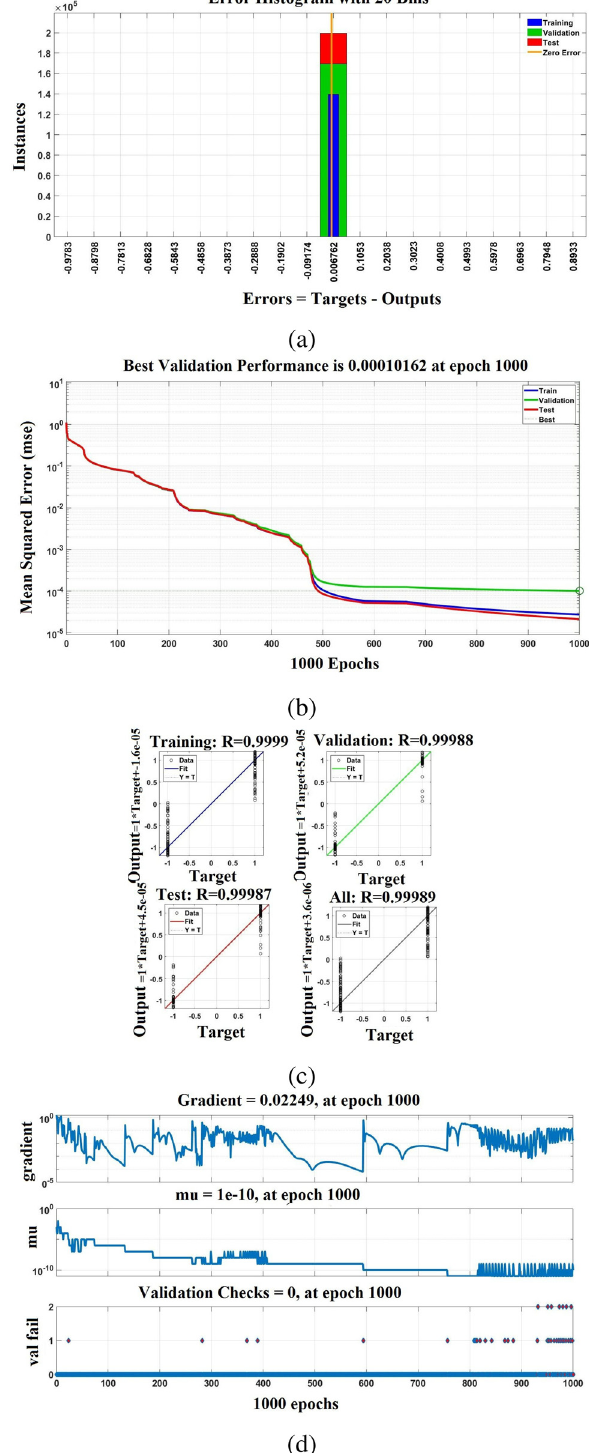
Figure 12: Proposed controller training on d - axis during LVRT cap - ability of DFIG system during grid fault: ( a ) histogram, ( b ) perfor - mance, ( c ) regression, and ( d )